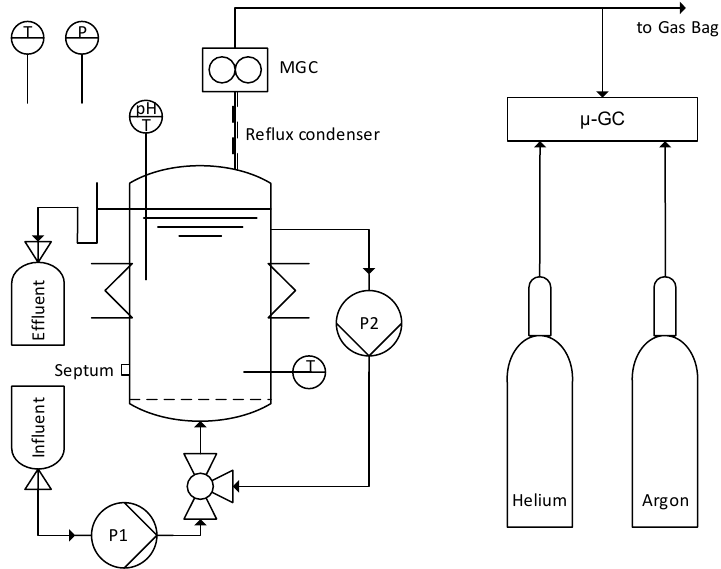
Figure 1. Piping and instrumentation of an anaerobic filter.